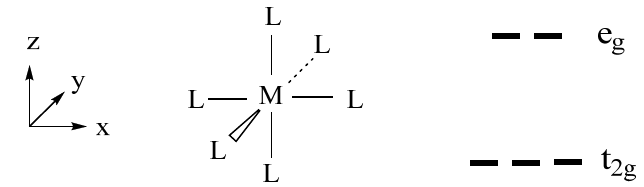
Figure 12. Transition-metal complex ML 6 octahedron and its d-orbital split pattern.